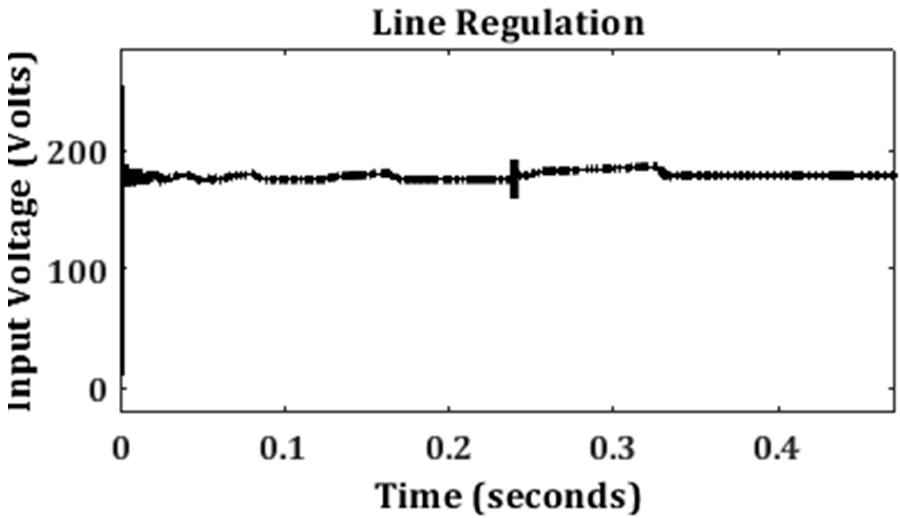
Figure 42. Input voltage in volts during the line regulation.